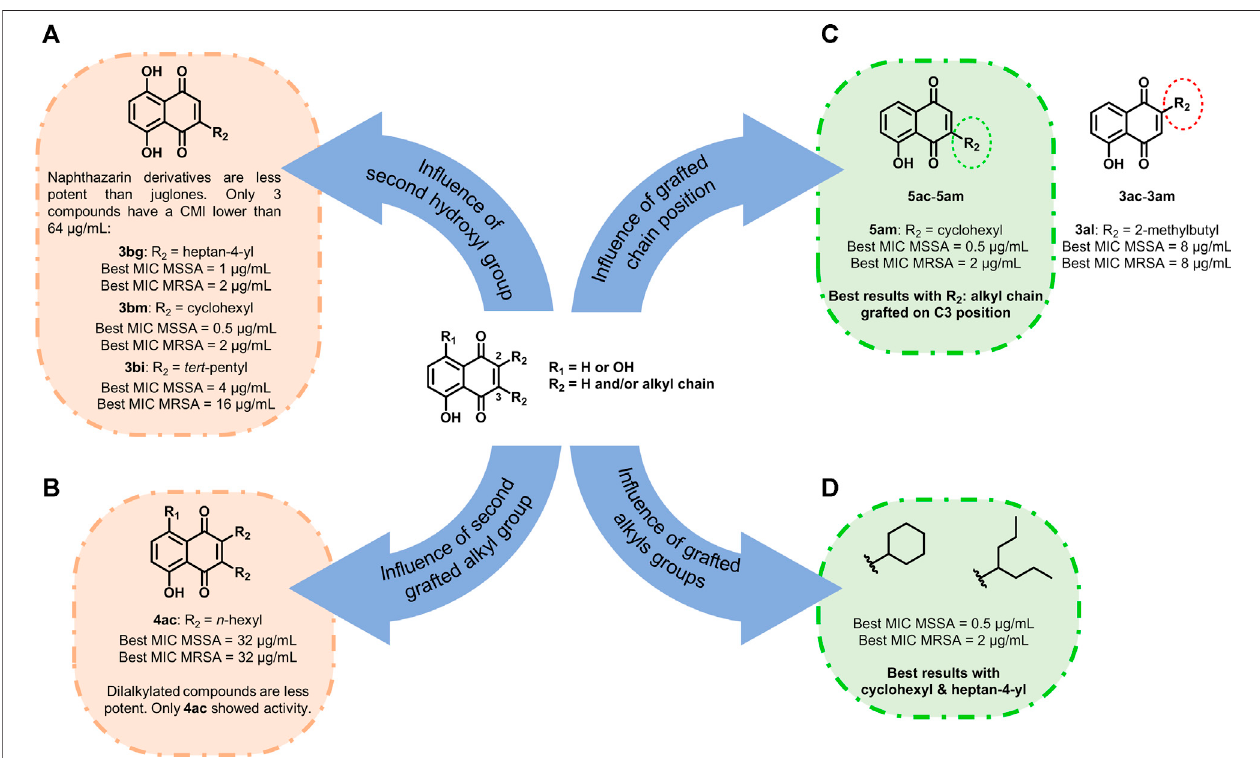
FIGURE 4 | Structure – activity relationship study of juglone and naphthazarin derivatives. (A) In fl uence of second hydroxyl group, (B) in fl uence of second grafted alkyl group, (C) in fl uence of grafted chain position, and (D) in fl uence of grafted alkyls groups.